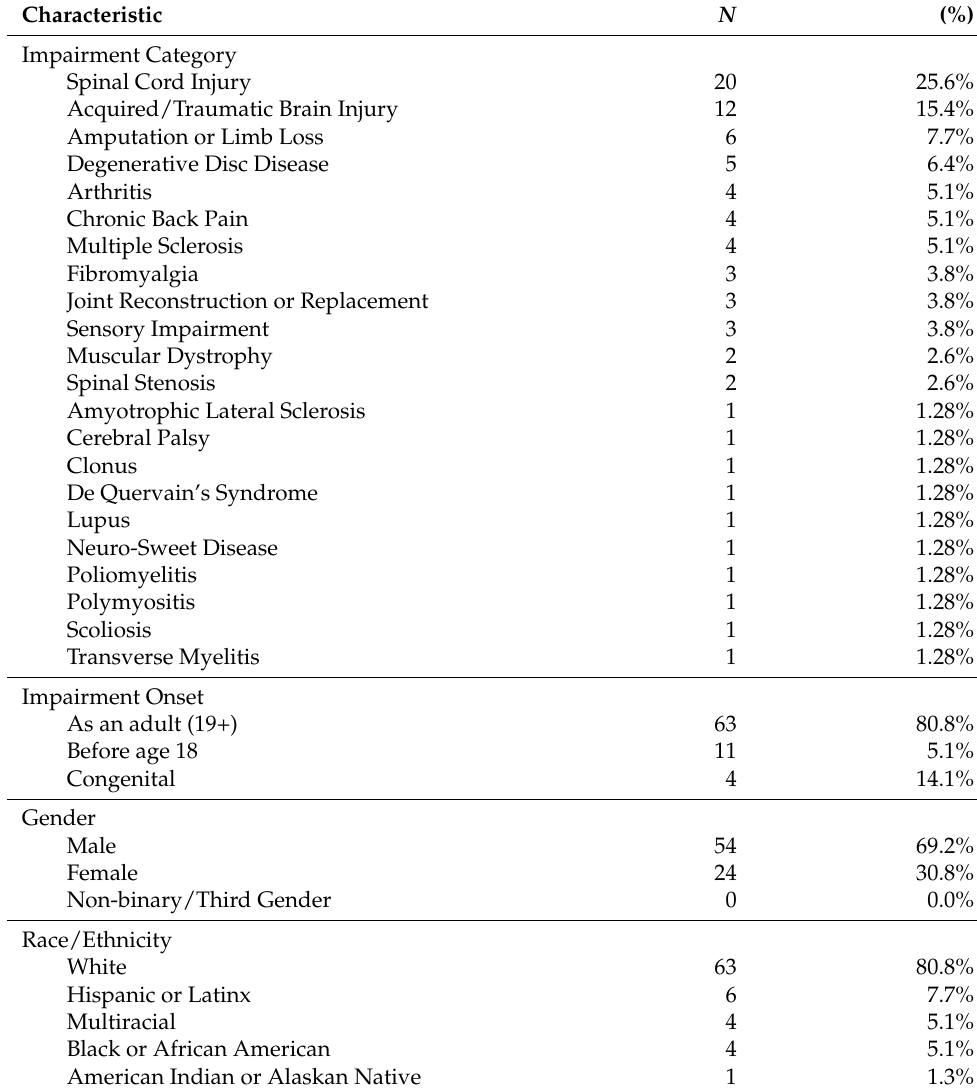
Table 2. Demographic characteristics of quantitative samples ( n =